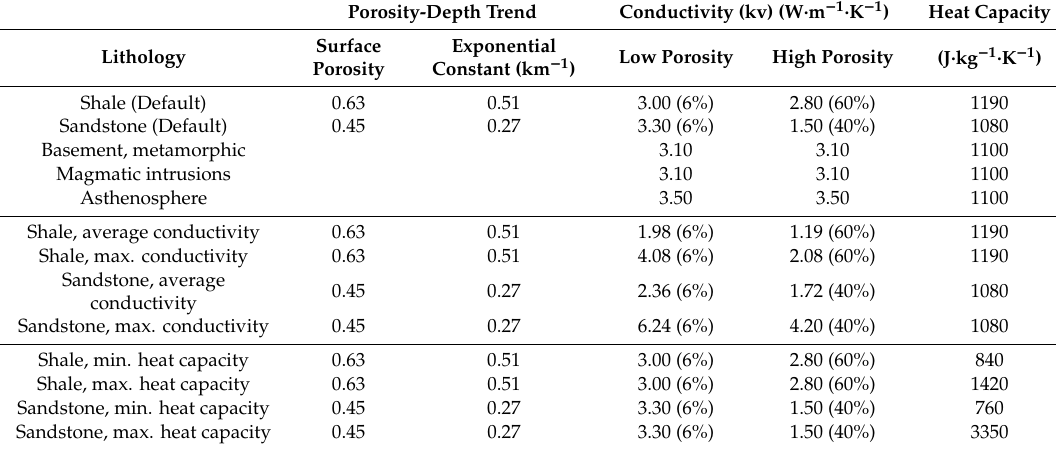
Table 2. Lithological parameters used in the modeling, based on standard values published in the literature (e.g., [37,38]).